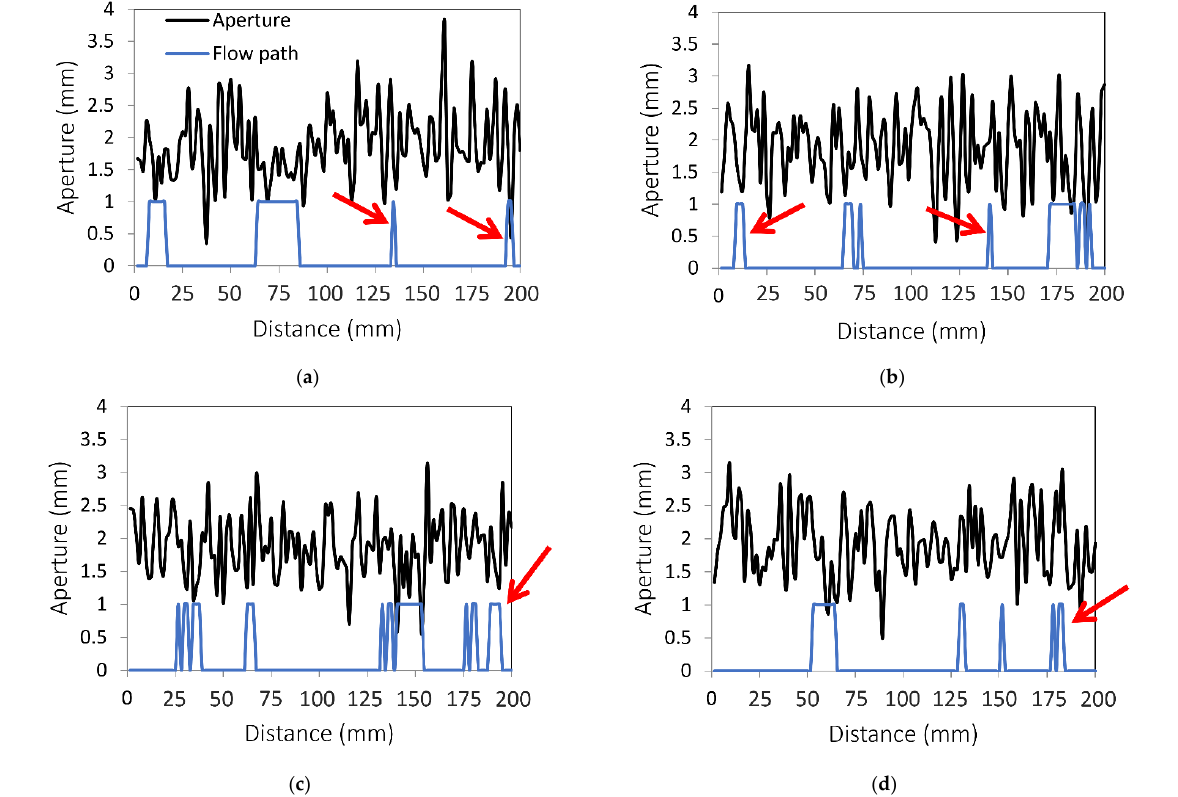
Figure 10. Flow paths along the aperture over cross sections: ( a ) A–A; ( b ) B–B; ( c ) C–C; ( d ) D–D. Red arrows indicate the flow paths with the maximum flow rate.